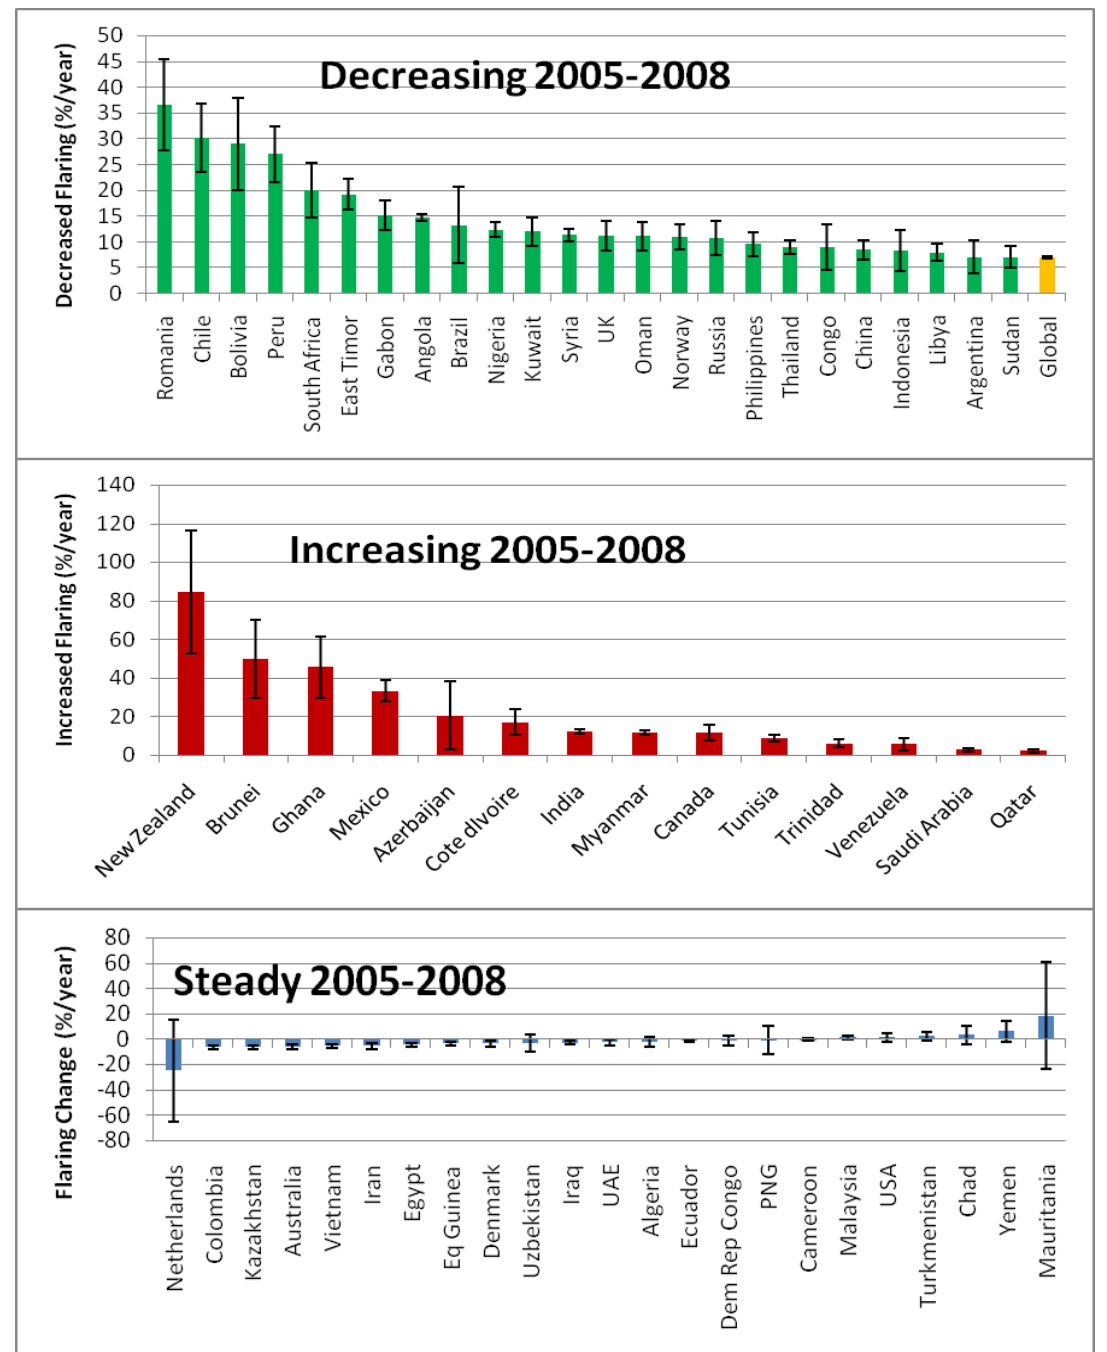
Figure 16. Flaring trends over the last four years (2005–2008). The rate of change over the years is plotted for each country where gas flaring was detected. They are grouped as ―Decreasing‖ if the rate of change is negative (and less than the uncertainty in the determination of the slope), ―Increasing‖ if the rate is positive, and ―Steady‖ if the absolute value of the slope is smaller than its uncertainty. Note that some countries with small decreases in gas flaring activity countries are rated as ―steady‖ based on the uncertainty of the change. The error bars indicate the uncertainty in the rate of